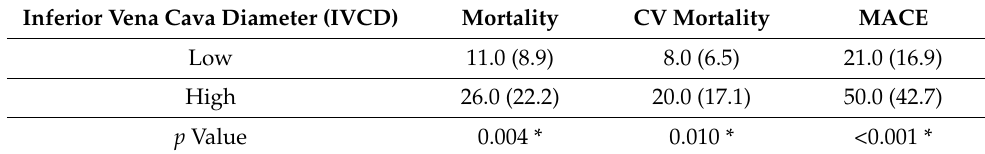
Table 3. Outcomes of chronic HD patients with functional AVA between high- and low-IVCD groups. Inferior Vena Cava Diameter (IVCD)